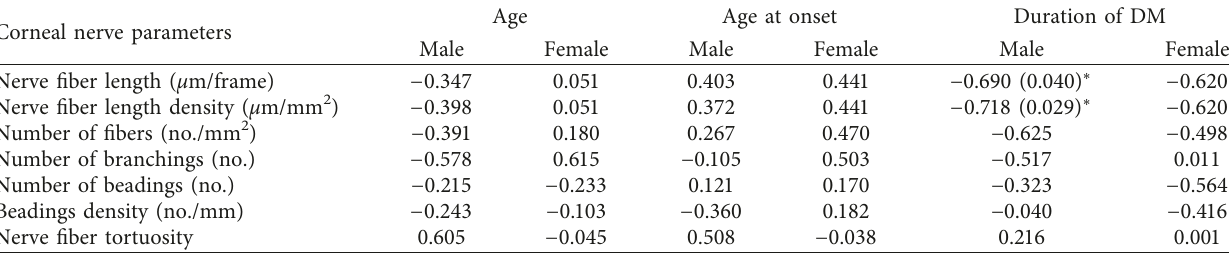
Table 6: Correlation r ( P < 0 . 05) of corneal parameters in the T1DM subgroup divided by sex and clinical data. Corneal nerve parameters